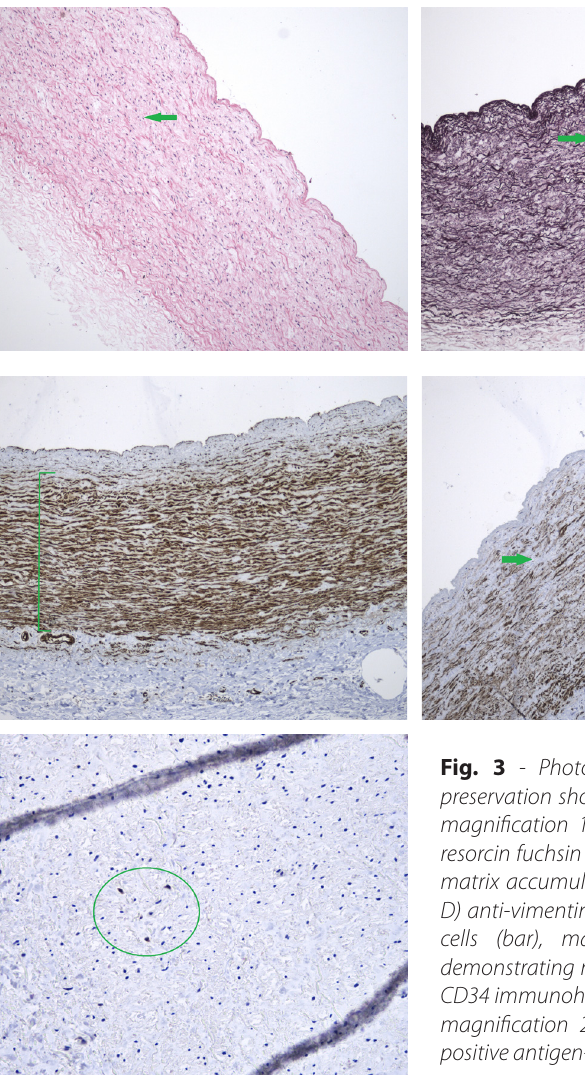
Brazilian Journal of Cardiovascular Surgery